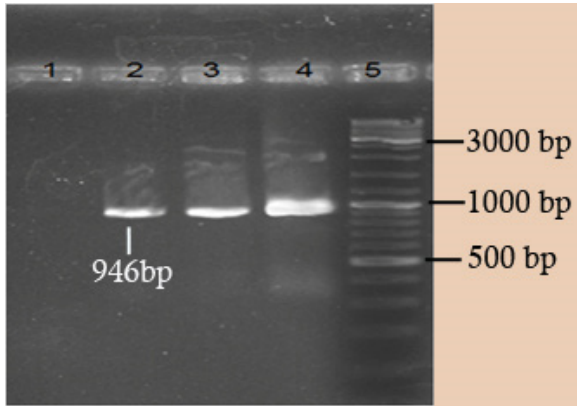
Figure 2 . Agarose gel electrophoresis analysis of PCR products. Lane 1, PCR product from pWB980 plasmid. Lane 2, 3, 4, PCR product from pWB980- dfpse plasmid. Lane 5, DNA marker SM0333 (Thermo).